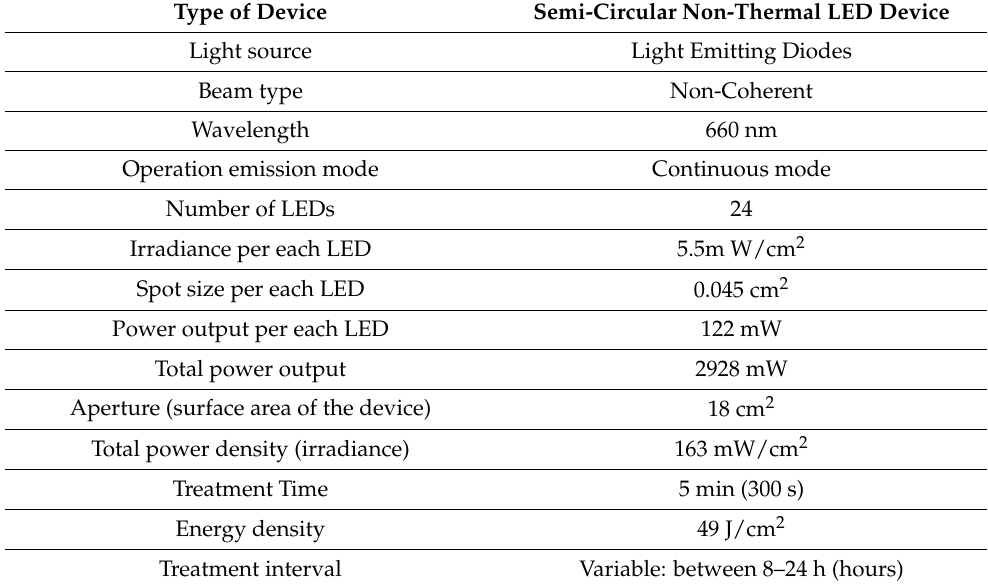
Table 2. Shows the device description and LED dosimetry and treatment protocols for photodynamic inactivation (PDI).